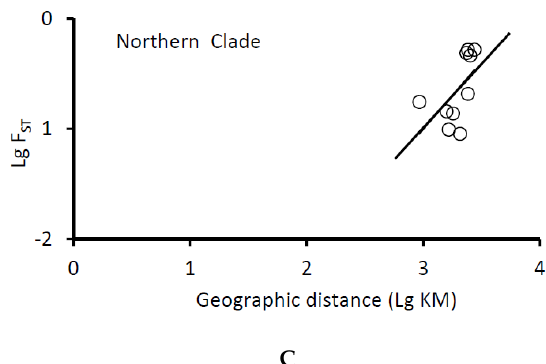
Figure 7. Plot of pairwise estimates of Log F ST vs. geographic distance (Log KM) between populations. (A) : all populations (B) : southern clade populations (C) : northern clade populations.